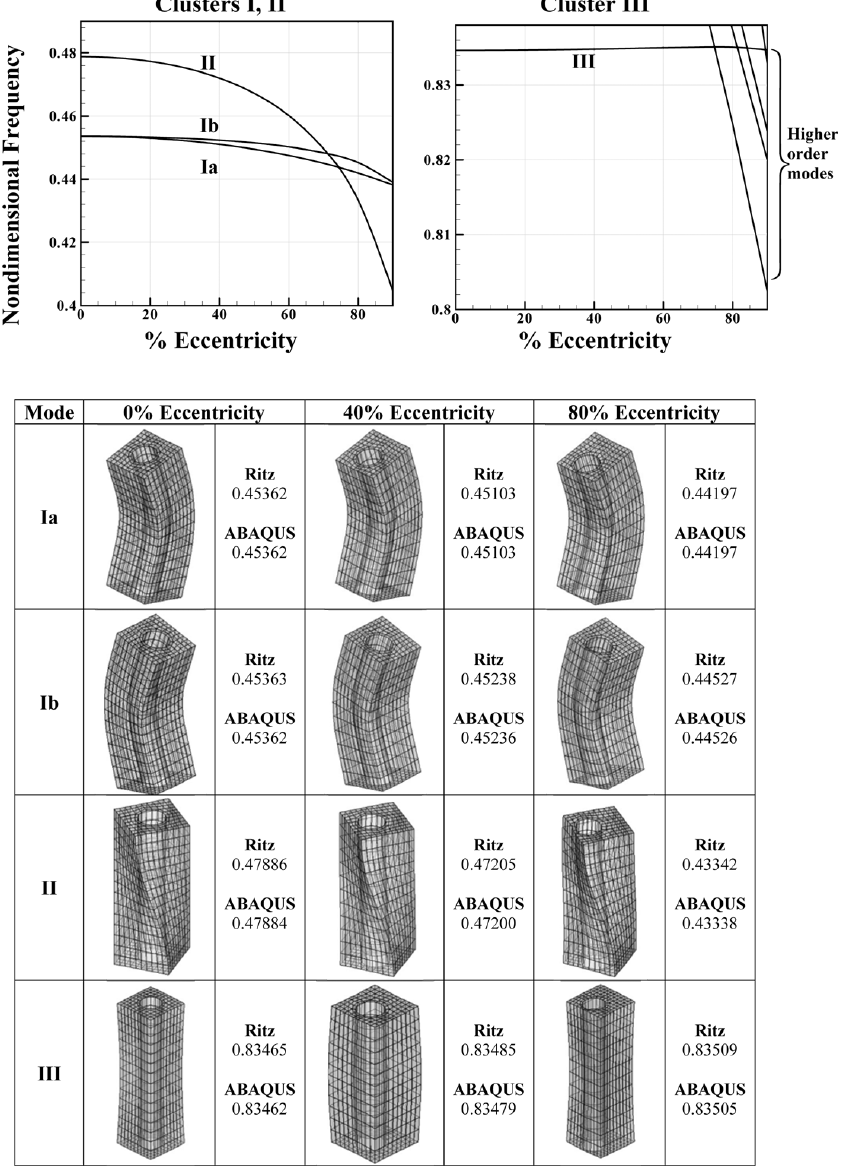
Fig. 3. Variation of the fi rst three frequency clusters with eccentricity parameter for the solid parallelepiped with an internal cylindrical cavity, along with the fi rst four three-dimensional mode shapes for selected eccentricity parameters. dimensionless geometric parameters; Fig. 2: L/b = 1, a/b = 0.5; Fig. 3: L/b = 3, a/b = 0.5, c/b = 1; Fig. 4: a/b = 0 . 5 , c/b = 1 , L/b = 1; Fig. 5: L/b = 1, a/b = 0.5; Fig. 6: a/b = 0.5. The fi rst four 3D